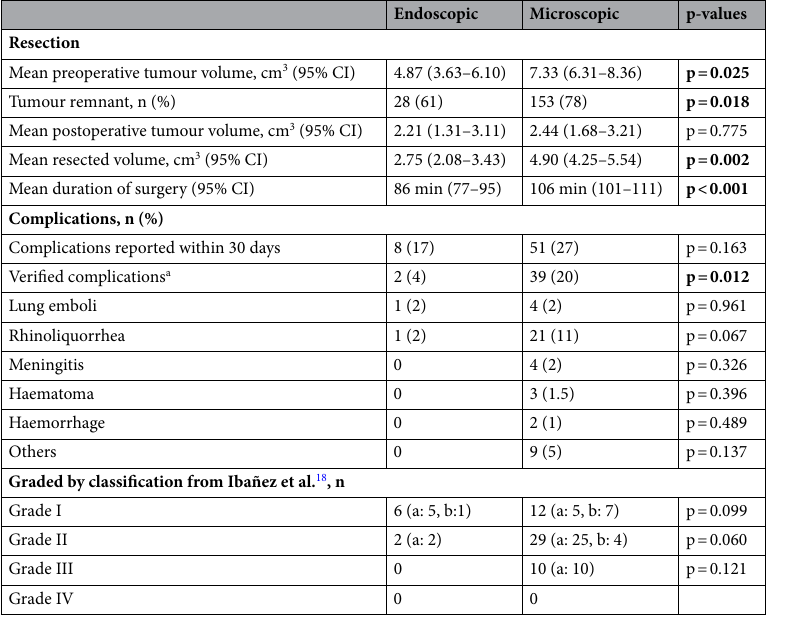
Table 2. Comparison of surgical outcomes and postoperative complications for patients with pituitary adenomas undergoing either endoscopic or microscopic surgery. p -values < 0.05 was regarded as stastically significant and highlighted in bold a By CT scan, Lumbar puncture and/or blood tests.